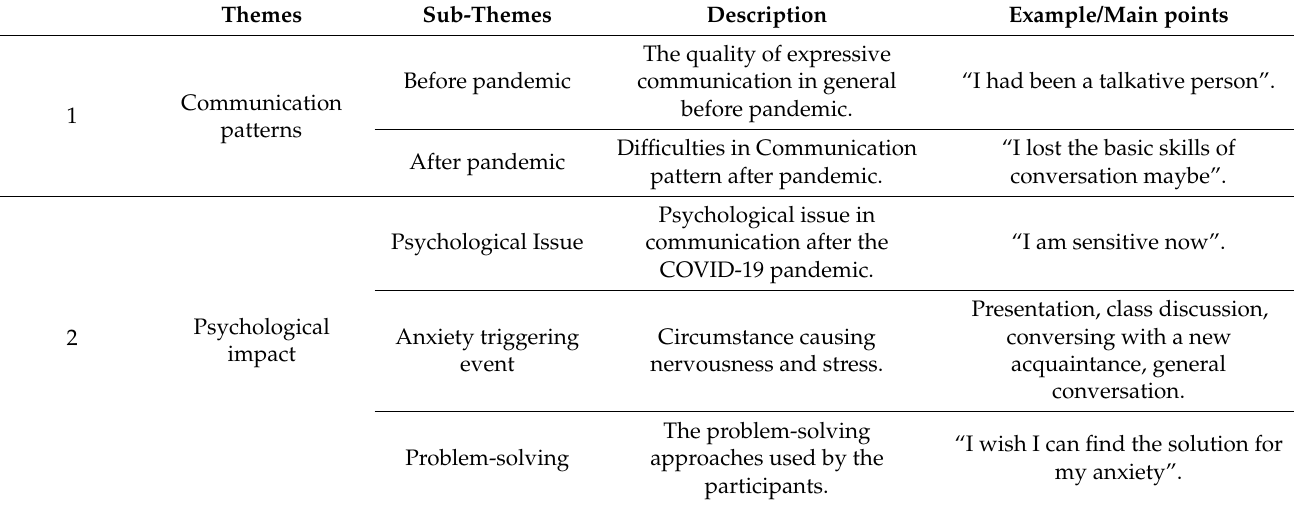
Table 8. Summary of